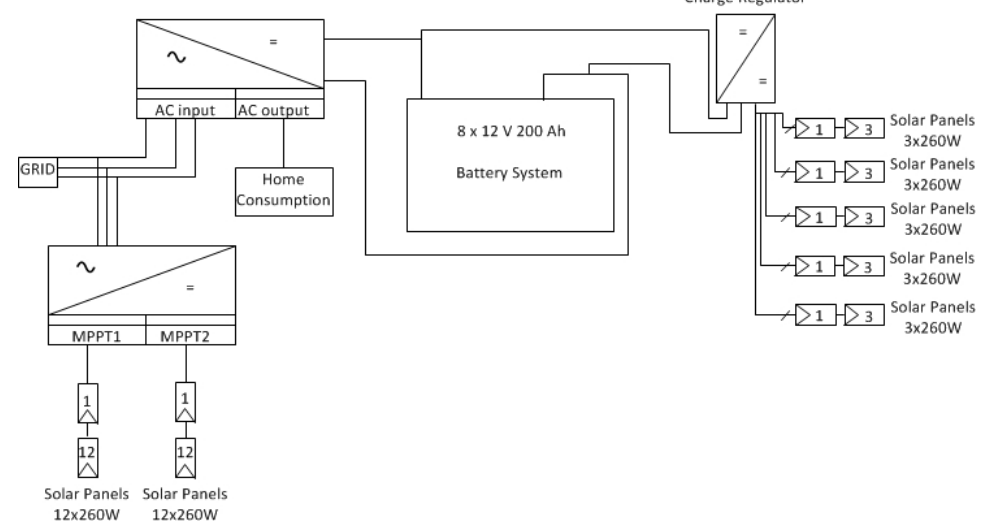
Figure 2. The electrical connections of all on/off grid inverters and batteries.